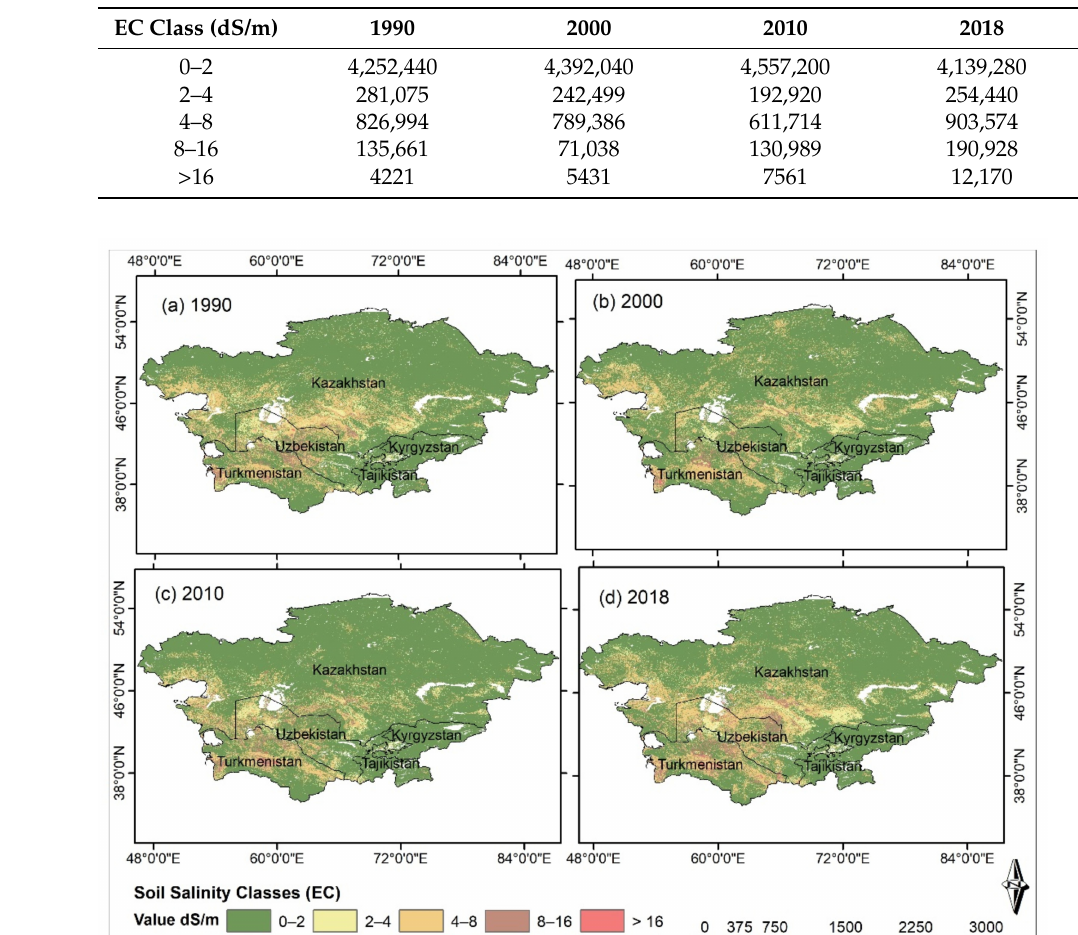
Table 3. Soil EC decadal variations (km 2 ) in Central Asia.